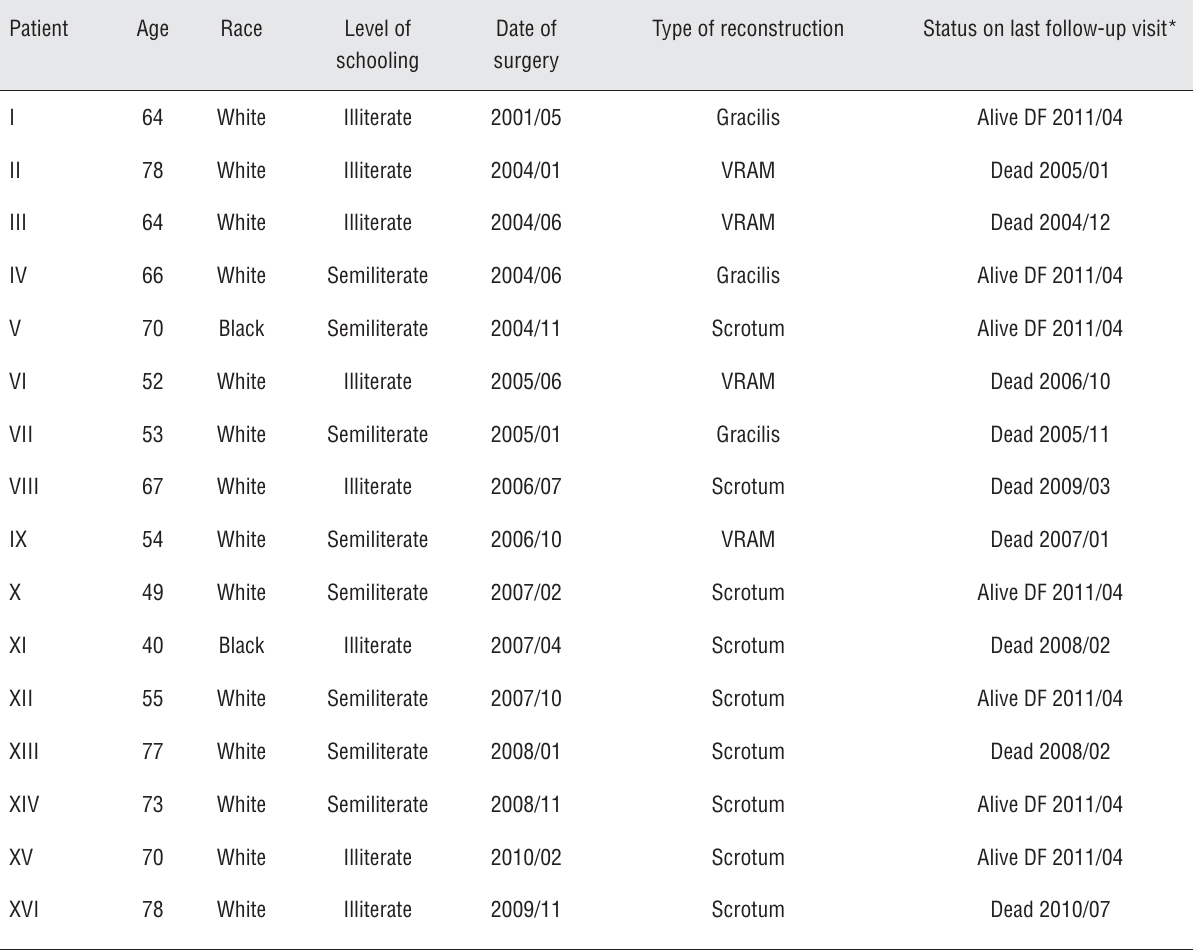
Table 2 - Demographic information, date of surgery, type of reconstruction and last follow-up visit of 16 patients with penile squamous cell carcinoma submitted to emasculation at the Ceará Cancer Hospital in Fortaleza, Brazil, between 1999 and 2010.